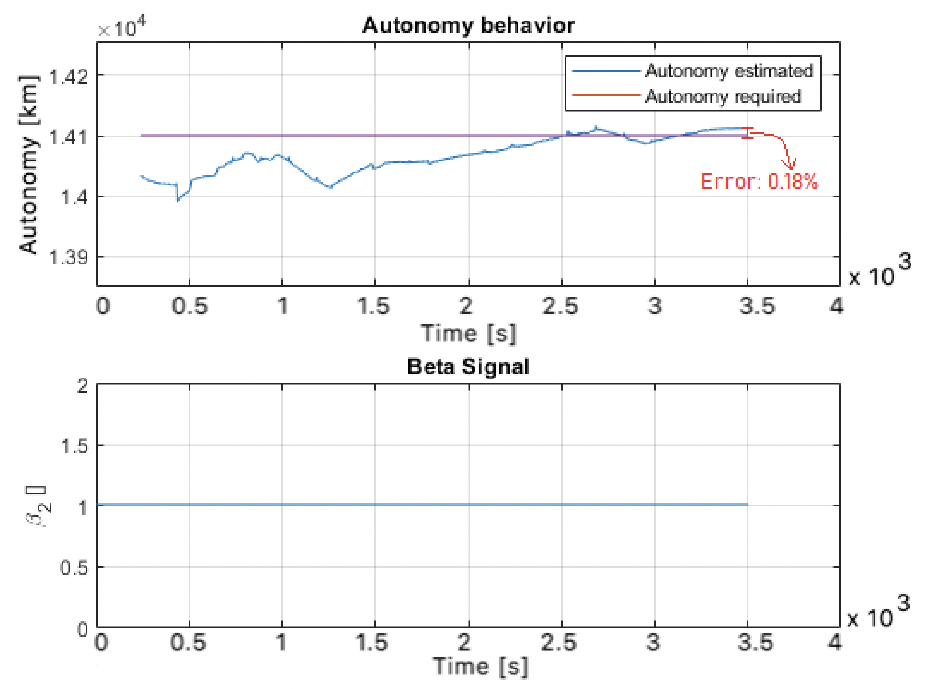
Figure 27. Case B, Good